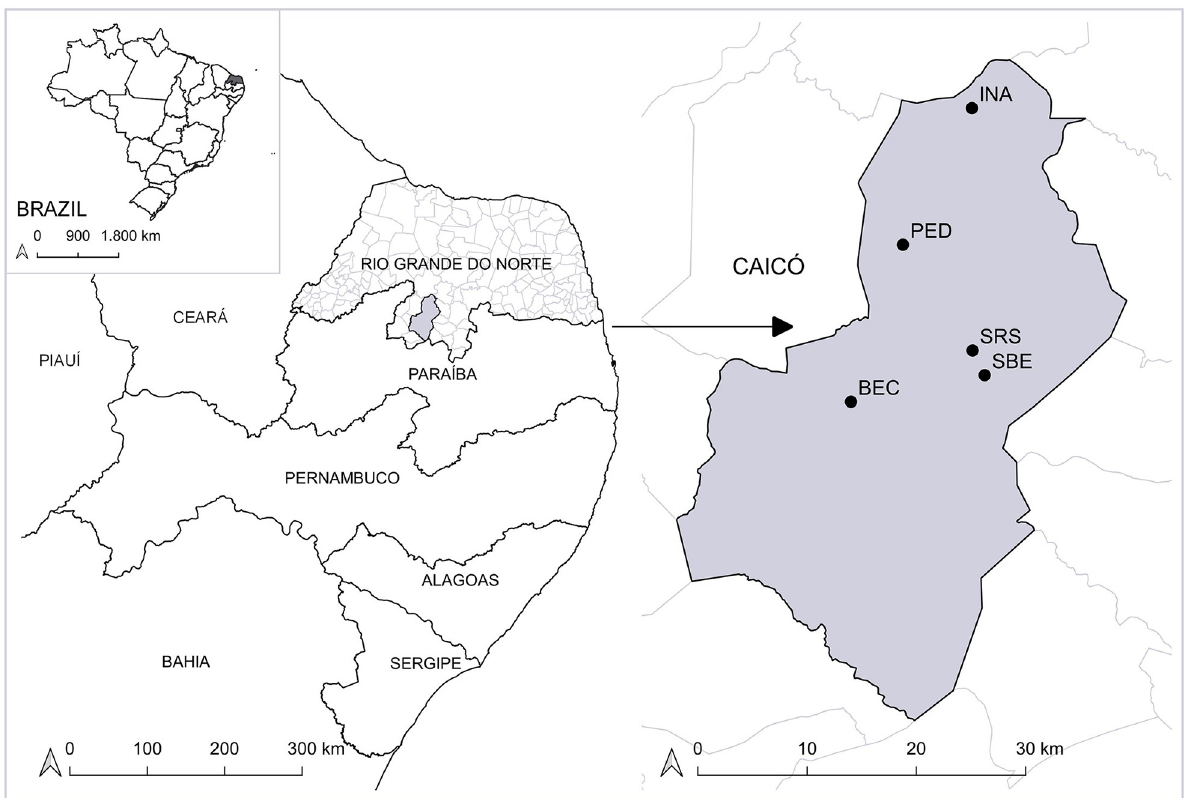
Fig 1. Geographical localization of collecting sites where triatomines were captured in Caico´ municipality, Rio Grande do Norte, Brazil. The Gray map shows the limit of the Caico´ municipality. Black dots indicate the small rural properties: Pedregulho (PED), Ina´cio (INA), S ã o Bernardo de Elias (SBE), Riacho do Santo (SRS) and the Batalh ã o de Engenharia de Construc¸ ã o (BEC). This map was created using QGIS 3.4 software and cartographic bases obtained from the Brazilian Institute of Geography and Statistics